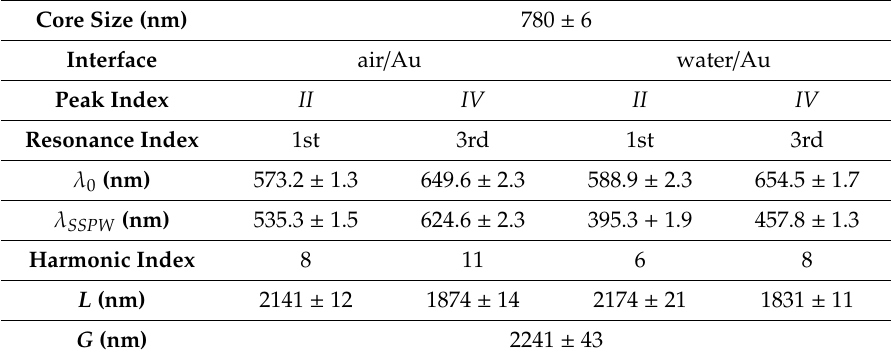
Table 3. Summary of concepts, numerical calculations, and measurements discussed in Section